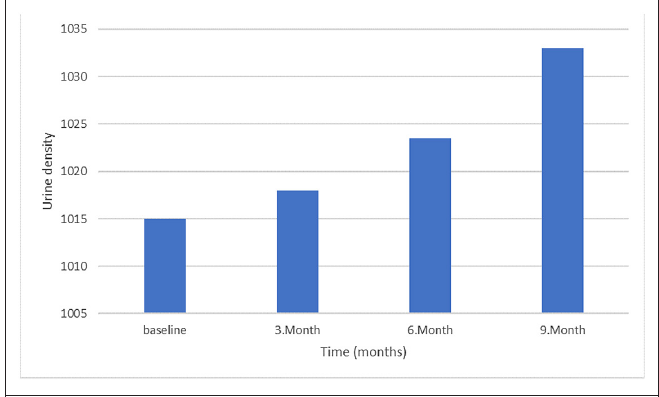
Figure 4. Temporal change of urine density ( P =